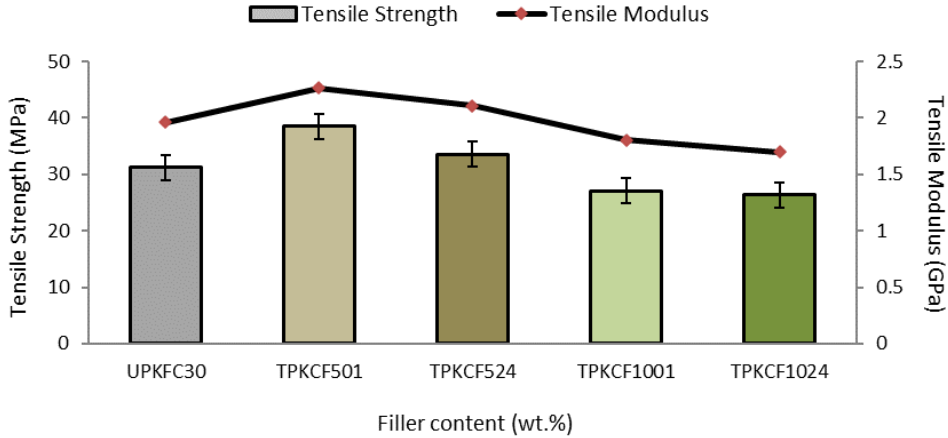
Figure 8. Effect of alkali treatment on PKCF/ER composites.